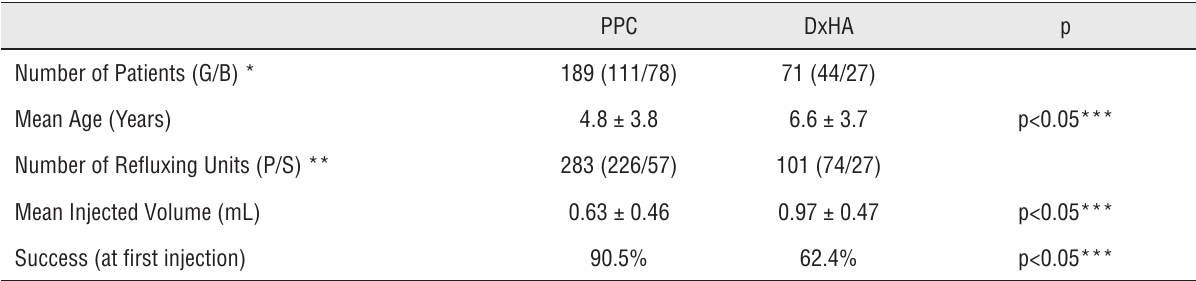
Table 1 - Comparison of PPC and DxHA